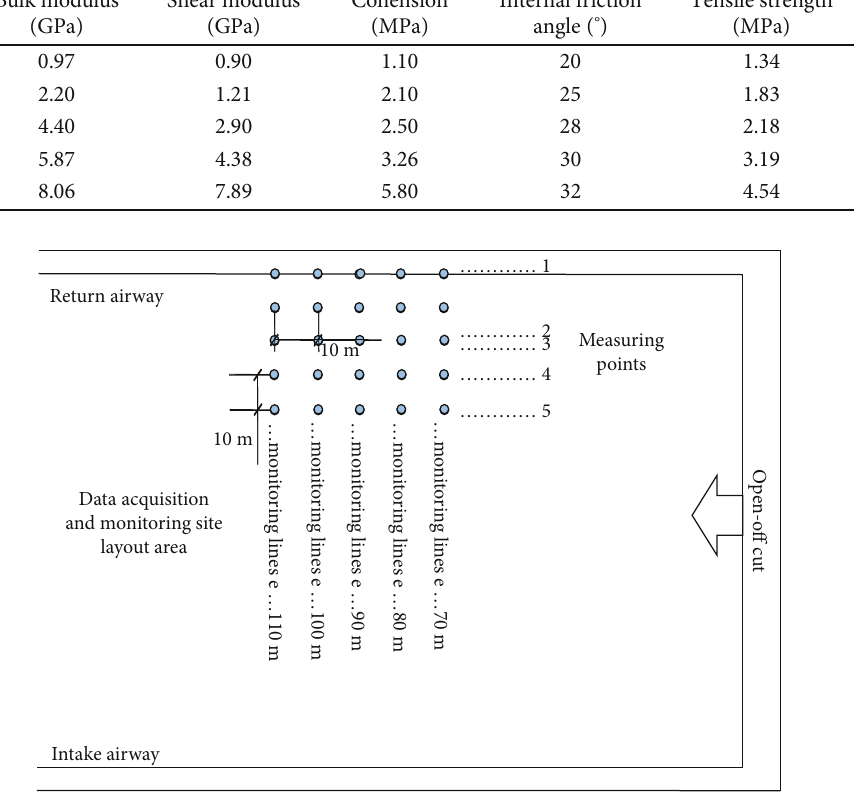
Figure 6: Schematic diagram of measuring